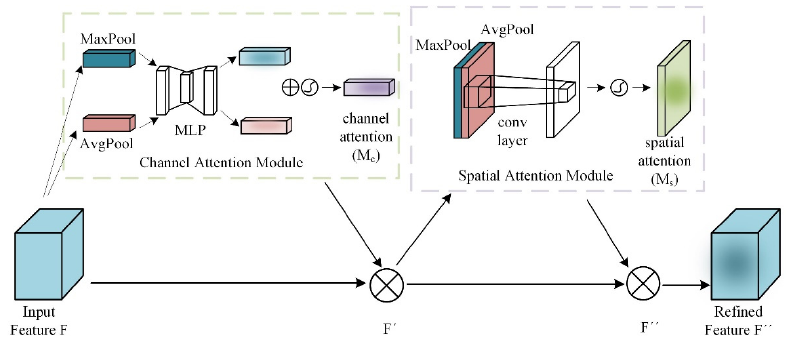
Figure 2. Workflow diagram of CBAM module.